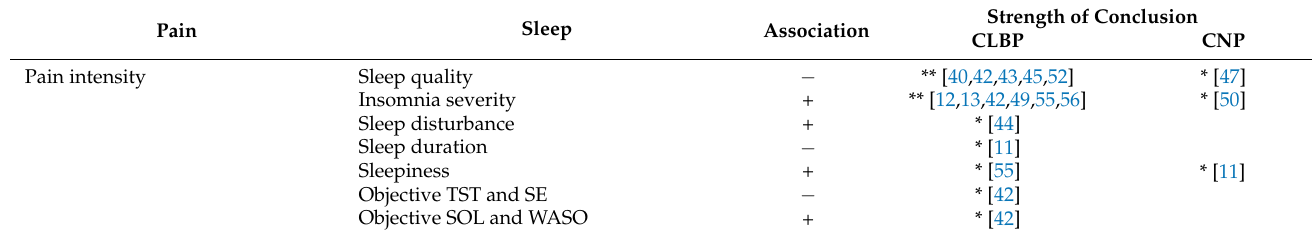
Table 9. Brief overview of the main results of the cross-sectional